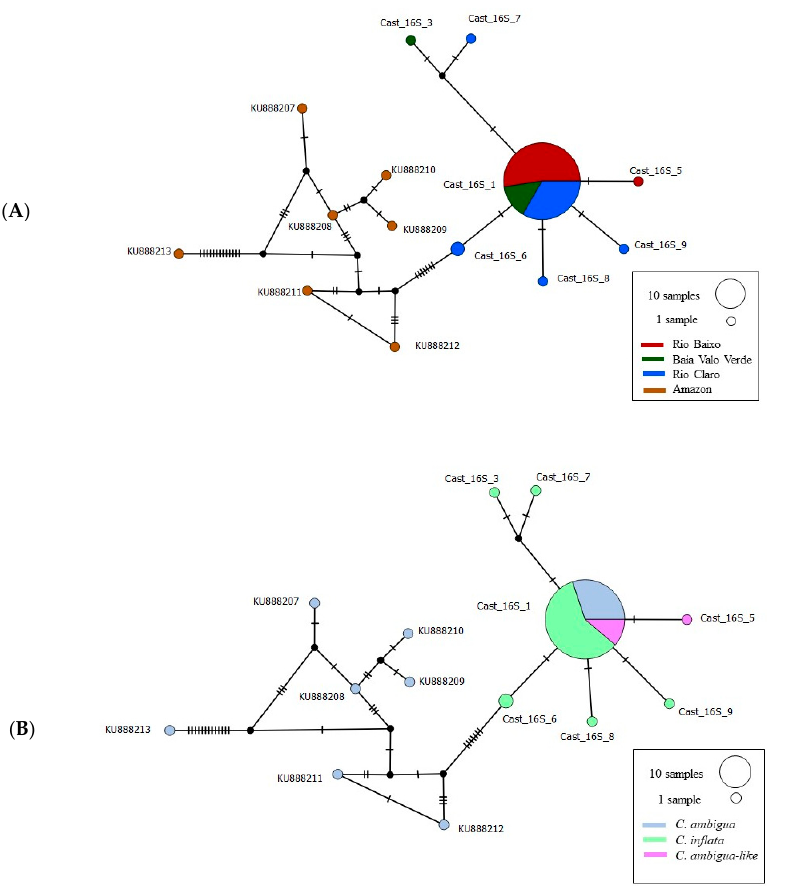
Figure 6. Haplotype networks for mitochondrial 16S rRNA for Castalia ambigua and C. inflata across the Paraguay and Amazon River basins, considered: ( A ). on a geographic basis, and ( B ). on a taxonomic basis. The relative sizes of the circles reflect the frequencies of the respective haplotypes. Hash marks indicate the number of inferred mutations among haplotypes observed. Black dots represent inferred intermediate haplotypes that were not observed in our data set. Haplotype designations include Cast for Castalia , 16S for 16S rRNA , and a number for each unique DNA sequence.